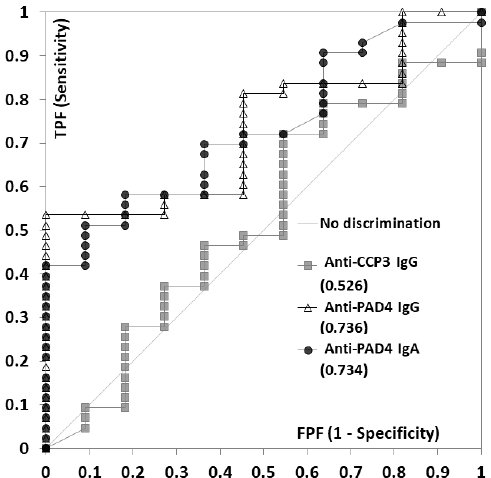
Figure 4. Anti-protein-arginine deiminase (PAD) 4 IgG and IgA and anti-cyclic citrullinated peptide (CCP) 3 in erosive rheumatoid arthritis (RA) ( n = 54). The receiver operating curve (ROC) analysis of anti-PAD 4 IgG (triangles) and IgA (circles), and CCP3 (squares) for the discrimination of RA erosive disease versus the absence of this manifestation. The area under the curve (AUC) is shown for each biomarker. Abbreviations: CCP: cyclic citrullinated peptide; PAD: protein-arginine deiminase; FPF: false positive fraction; TPF: true positive fraction.